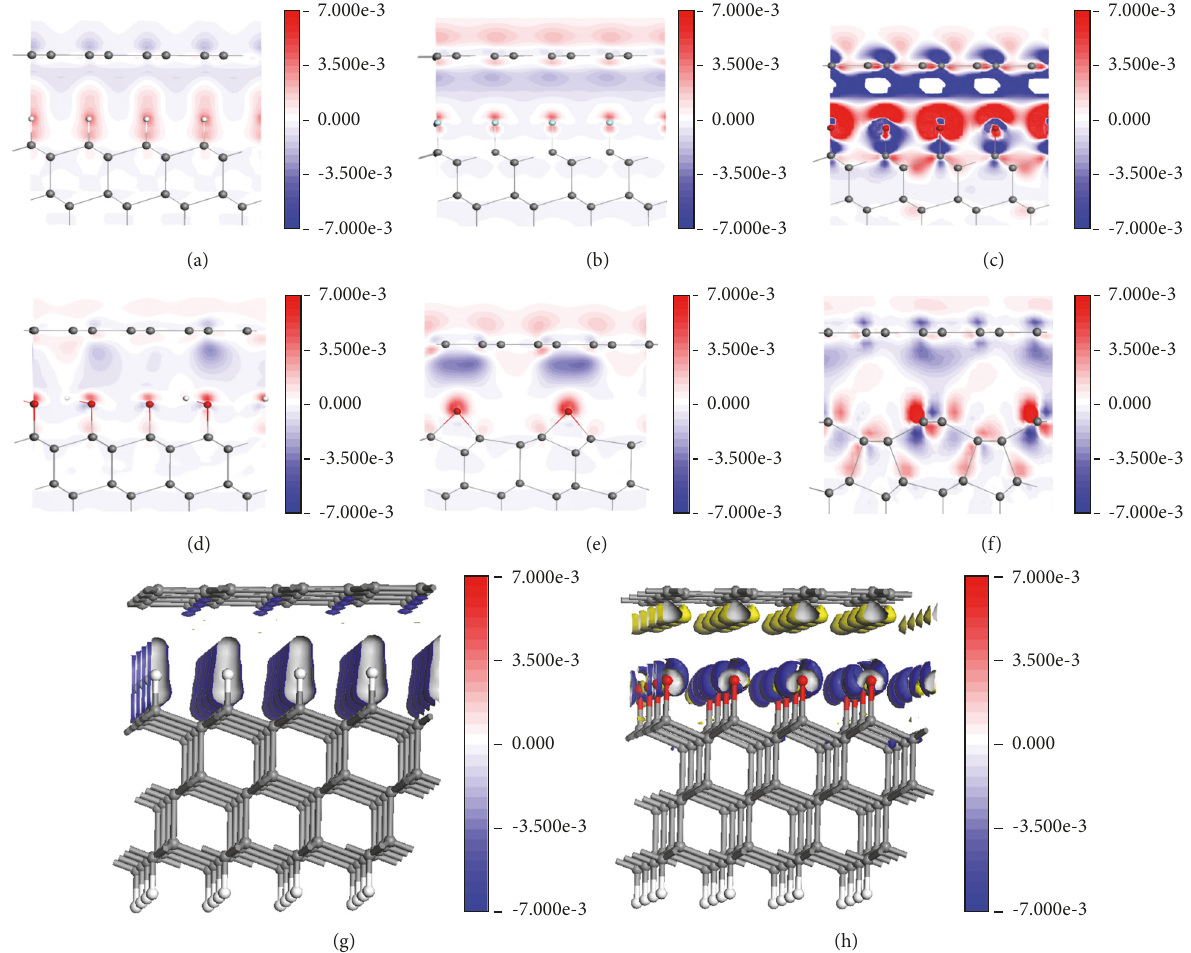
Figure 2: Side view of the electron density difference for a (a) GHD system, (b) GFD system, (c) GO D system, (f) GD2 × 1 system, (g) GHD system, and (h) GO (e) GO bridge isosurface for (h) was set to 0.015/˚A. The H, O, C, and F atoms are shown in white, red, gray, and green, respectively. The colour scale in the plots goes from (cid:2) 𝜌 =-0.007/˚A 3 (blue) to (cid:2) 𝜌 =0.007/˚A 3